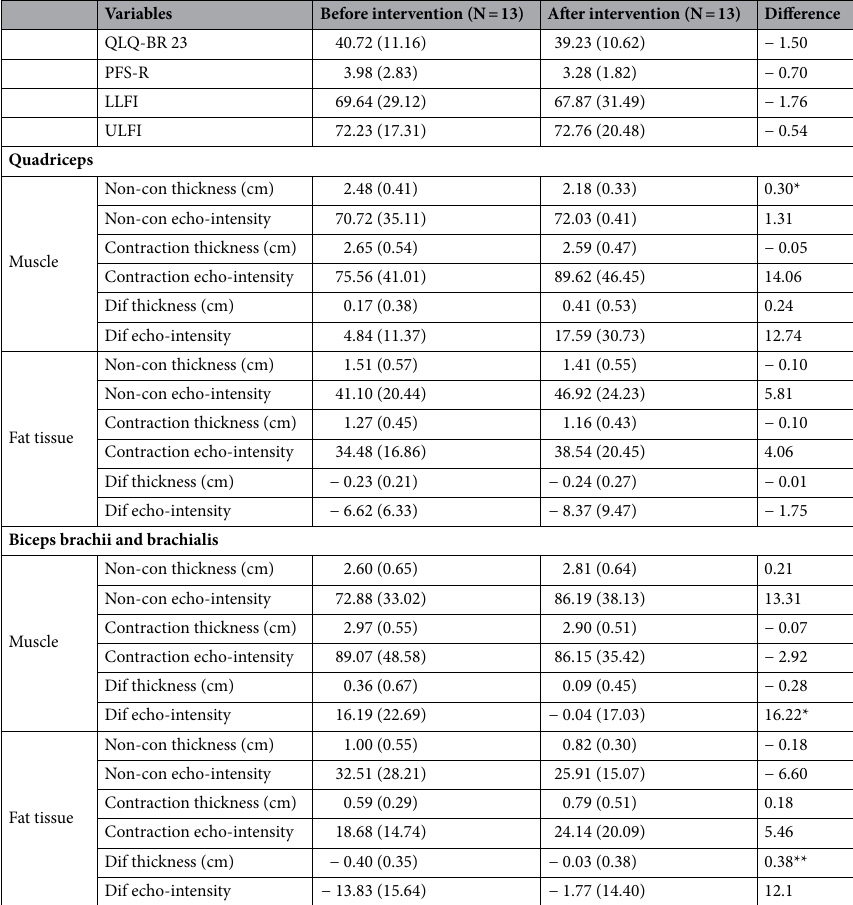
Table 2. PRO and US imaging results before and after intervention. Dif, Difference; QLQ-BR, Quality of Life Questionnaire Breast Cancer; PFS-R, Piper Fatigue Scale-Revised; LLFI, Lower Limb Functional Index; Non- con, no contraction; ULFI, Upper Limb Functional Index; PRO: Patient-Reported Outcomes; US: Ultrasound imaging. *p < 0.05; **p <